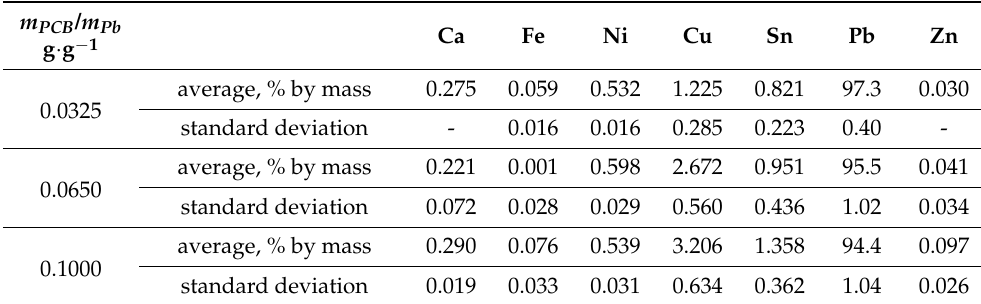
Table 8. Chemical compositions of the lead ingots after melting with PCB pyrolyzate “new”, averages and standard deviation of 3 analyses.